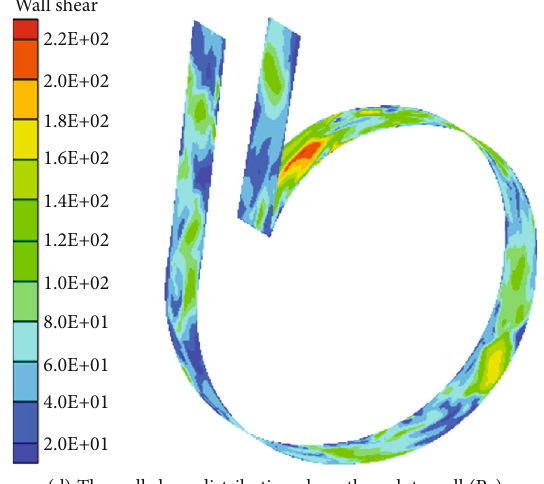
Figure 4: Several important parameter distributions in the volute.